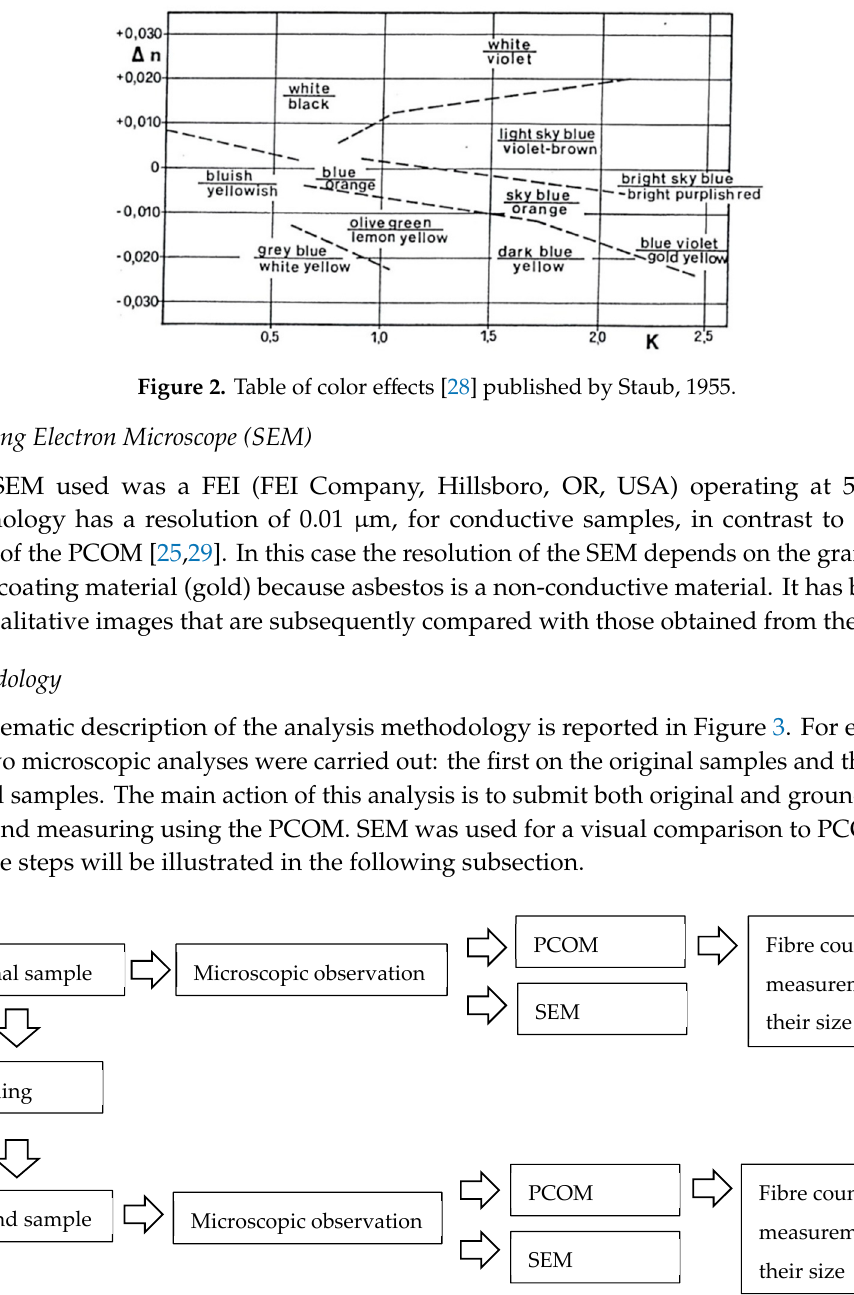
Figure 3. Analysis procedure flowsheet.